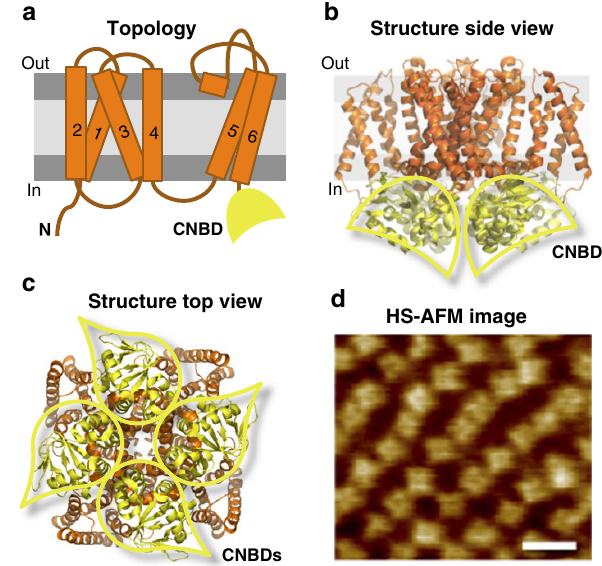
Figure 1 | Architecture of MloK1. ( a ) Topology of one subunit with six transmembrane segments (orange); the C-terminus contains the CNBD (yellow). The voltage sensor (S1–4) and the pore (S5–6) are in the transmembrane region. Atomic model based on the cryo-EM MloK1 structure (PDB 4CHV, ref. 15), in ( b ) side and ( c ) top views, respectively. The CNBDs arrange in a wind mill-like fashion (yellow outlines). ( d ) High- resolution HS-AFM topograph of MloK1 in 2D crystals in presence of 100 m M cAMP. Scale bar: 15nm. Full colour scale: 2nm. NATURE COMMUNICATIONS|7:12789|DOI: